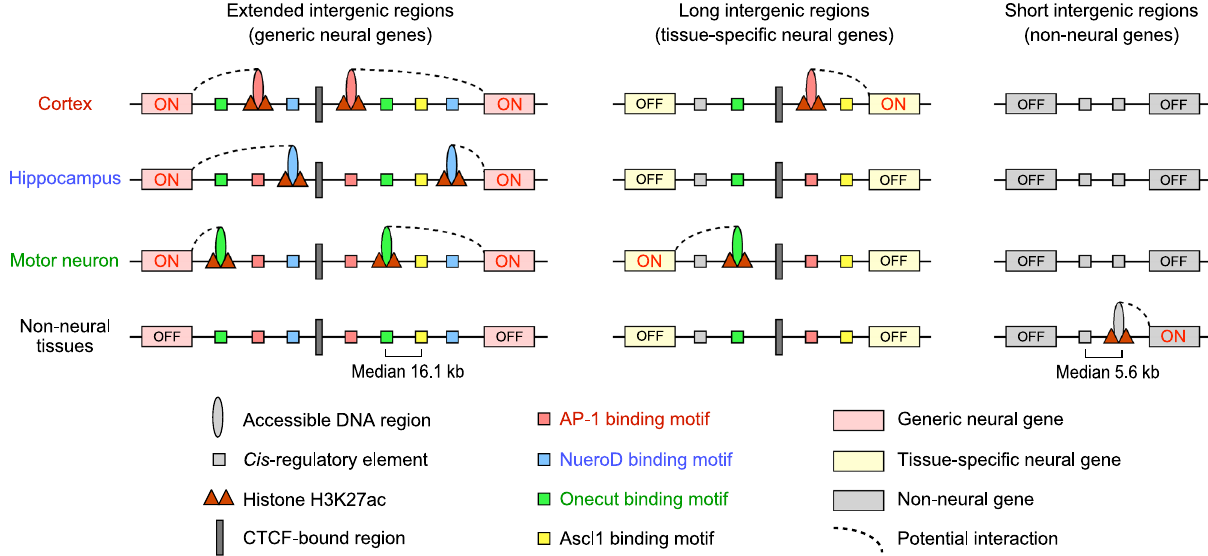
Fig. 9 Extended intergenic regions contain distinct tissue-speci fi c enhancers contributing to the expression of neighboring neural genes. We propose that generic neural genes expressed in multiple neural tissues have extended intergenic regions (median length: 180.7 kb) with an average of 8 neural tissue-speci fi c enhancers (median 16.1 kb between the closest enhancers per intergenic region; Supplementary Figs. 5, 8d). Tissue-speci fi c neural genes also have signi fi cantly longer intergenic regions than non-neural genes. Neural genes mostly share their intergenic regions with neighboring neural genes, having many cell- and tissue-speci fi c intergenic enhancers bound by the distinct neural TFs. These neural TFs sites are chromatin accessible and enriched with acetylation of H3K27 in a tissue-speci fi c manner. An insulator binding protein, CTCF, binds to commonly accessible DNA sites in the intergenic regions. As a result, co-expression of neighboring neural genes is controlled mostly by distinct intergenic enhancers rather than common enhancers. We propose that a large number of neural cis -regulatory elements in extended intergenic regions lead to tissue- and developmental-speci fi c neural gene expression in the complex mammalian nervous